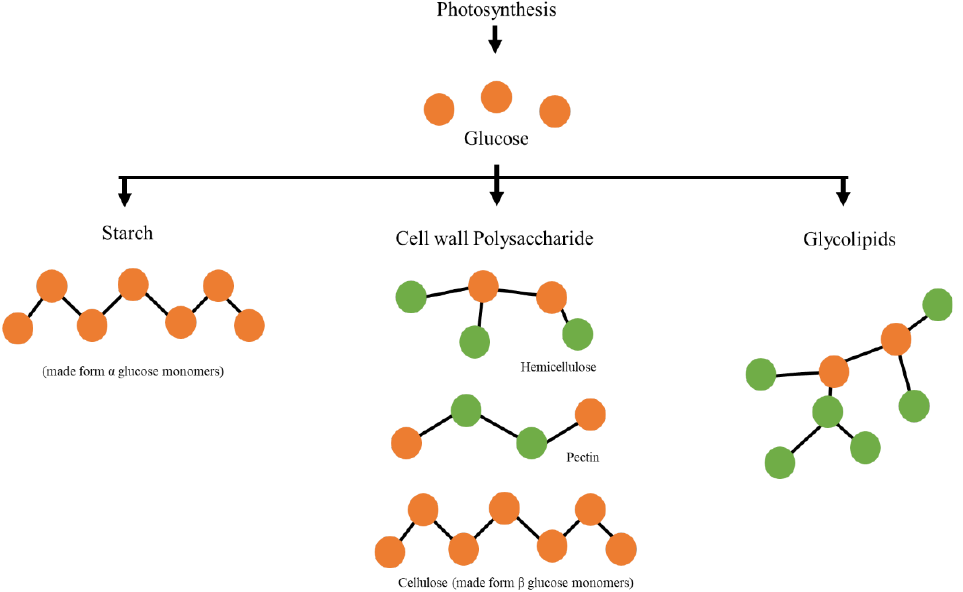
Figure 2. The formation of various compounds from glucose monomers. The green circles are indic- ative of all other compounds, such as xylose, arabinose, and glucuronic acid [60 – 62]